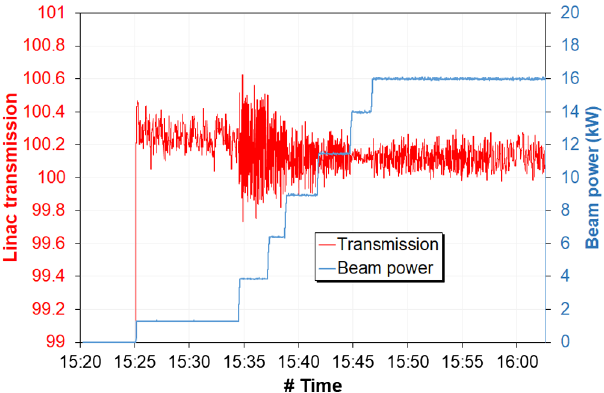
FIG. 14. Transmission in the SC linac (red) and beam power (blue) during the beam power ramp-up to 16